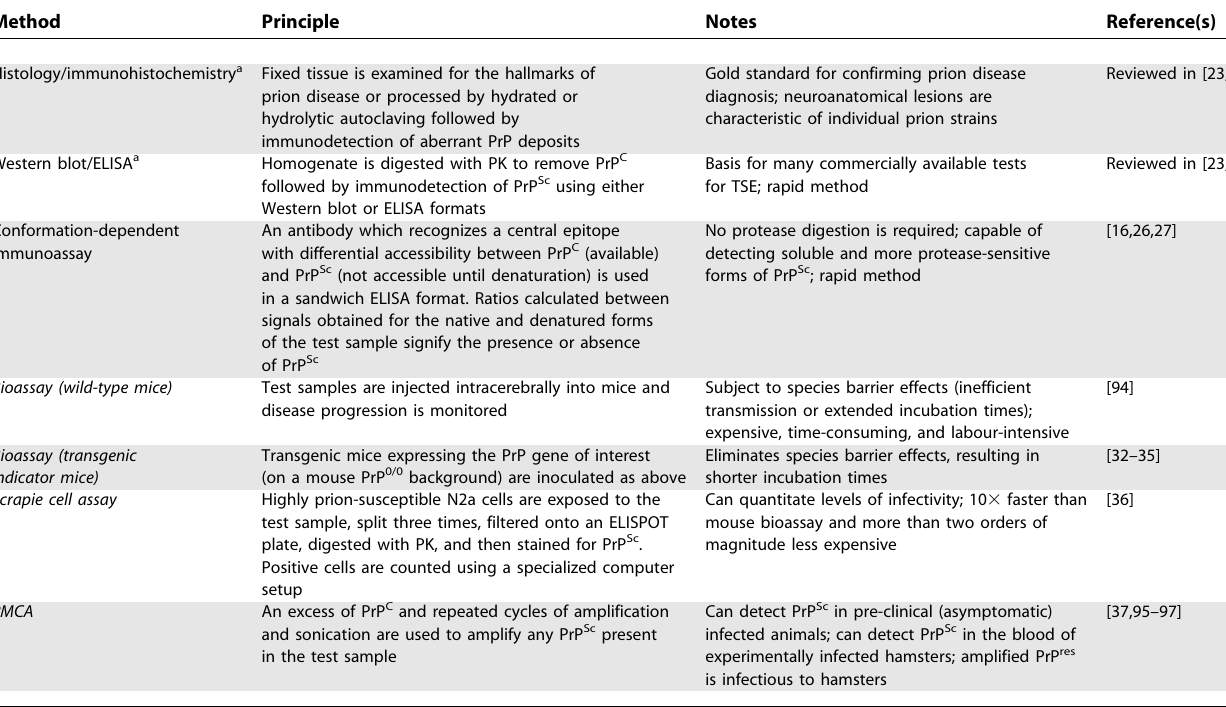
Table 1. Commonly Used Methods for Detecting TSE and PrP